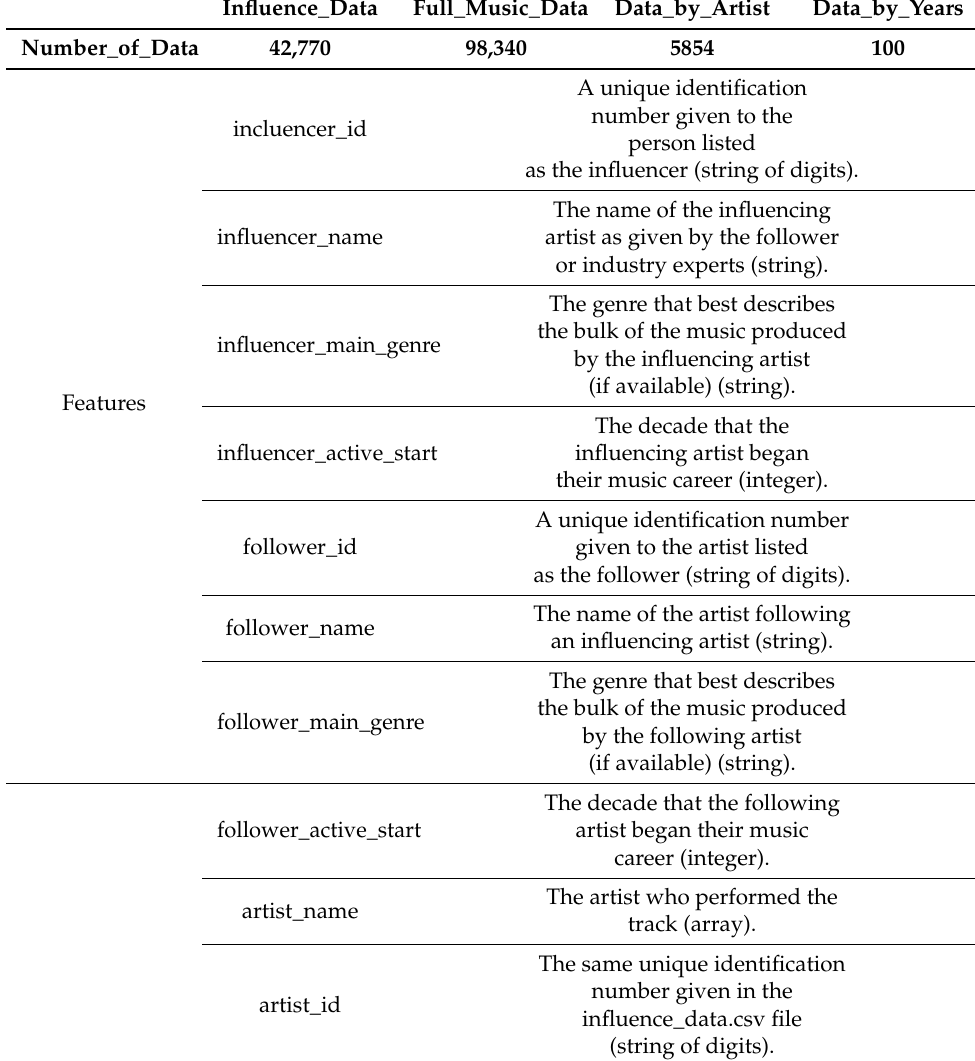
Table 2. Dataset description